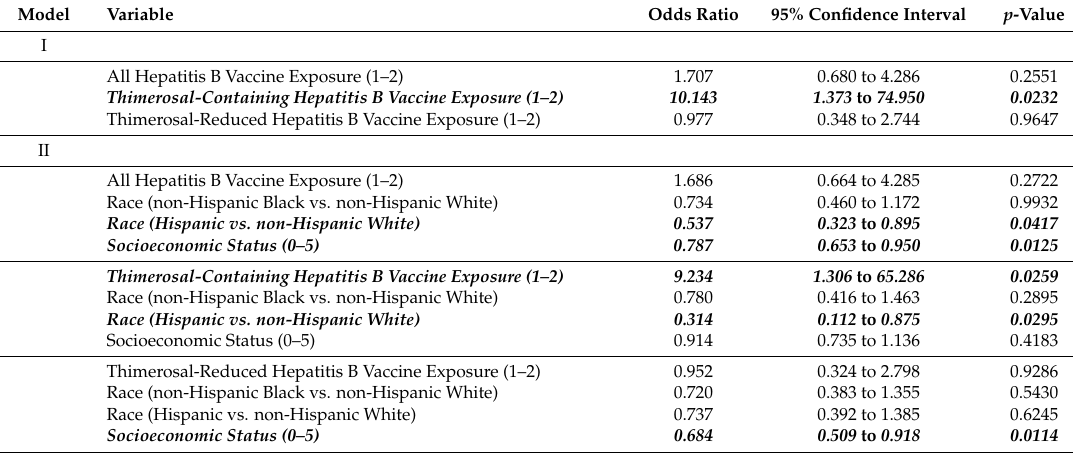
Table 2. A summary of survey logistic regression models 1 generated to examine the potential relationship between infant hepatitis B vaccine exposure and the risk of adverse effects as measured by receipt of special education services.